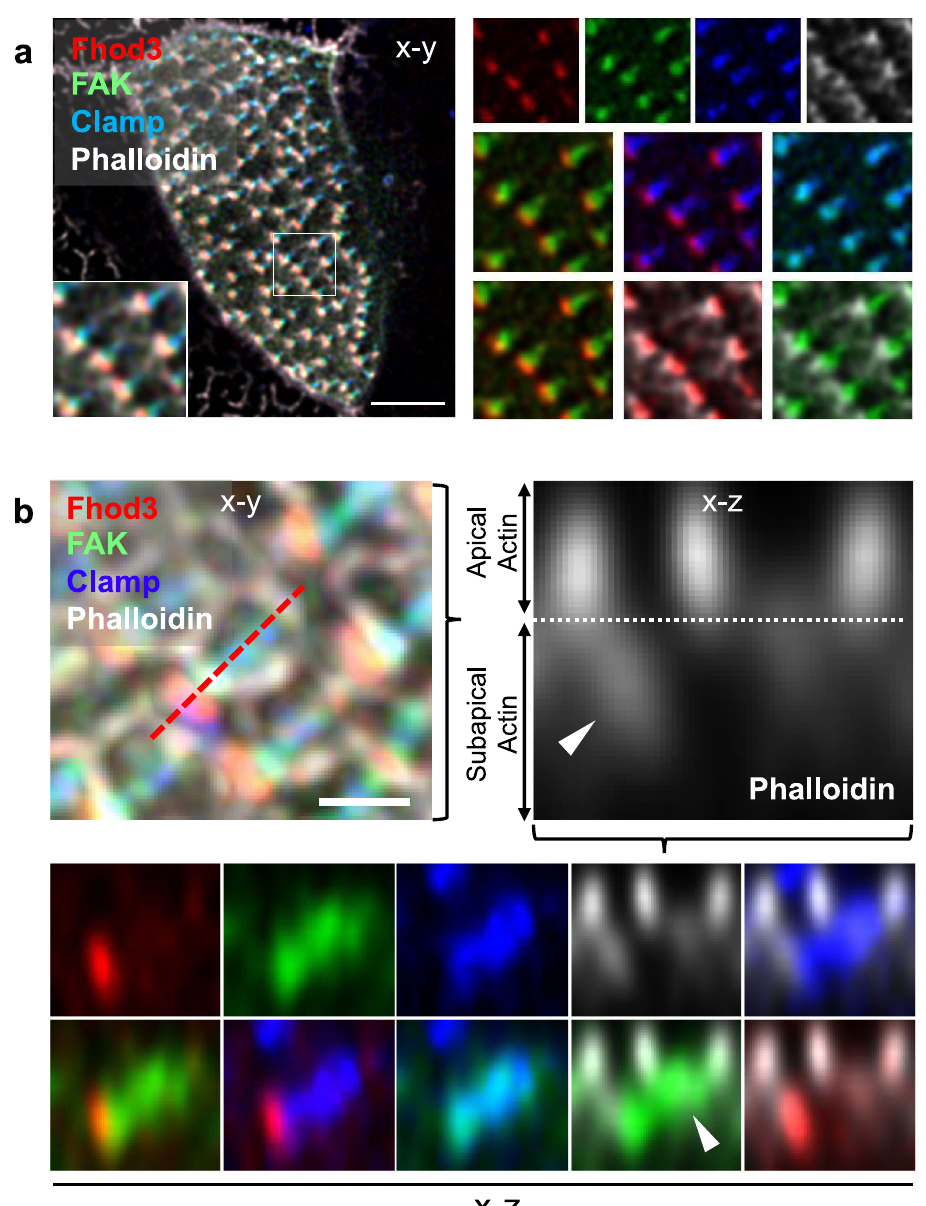
Fig. 4 Fhod3 localizes to the tip of the anterior rootlet. a Fhod3 (RFP, red) localizes to the distal end of the anterior rootlets (labeled with BFP-Clamp, blue) in between phalloidin (white)-labeled actin fi laments and GFP-labeled FAK (scale bar, 5 µ m). Magni fi ed images depict the pair-wise comparison of fl uorescent proteins. b The x-z projection reveals the presence of Fhod3 at the distal tip of the anterior basal body rootlet within the subapical actin layer. The left upper image depicts the maximal intensity projection of the confocal section used for 3D reconstruction (scale bar, 1 µ m). The right upper picture represents a magni fi cation of the phalloidin (white)-labeled image, depicting the border (dashed line) between apical and subapical (arrowhead) actin layer. While Fhod3 (RFP, red) labeled the tip of the anterior rootlet (BFP-Clamp, blue), FAK (GFP, green) localized to the more proximal part of the rootlet (arrowhead). Magni fi ed images depict the pair-wise comparison of fl uorescent proteins. Images were obtained at stage